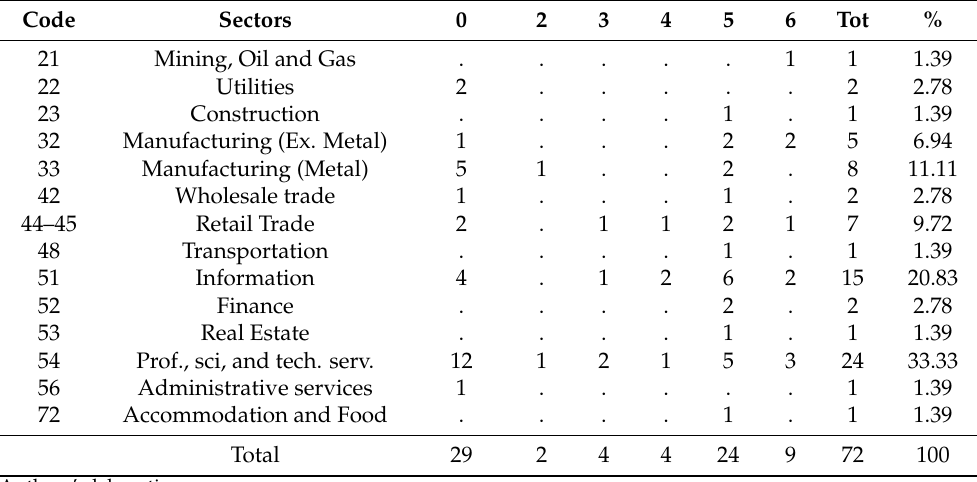
Table 4. Occurrences of heterogeneity in spin-out sectors. Code